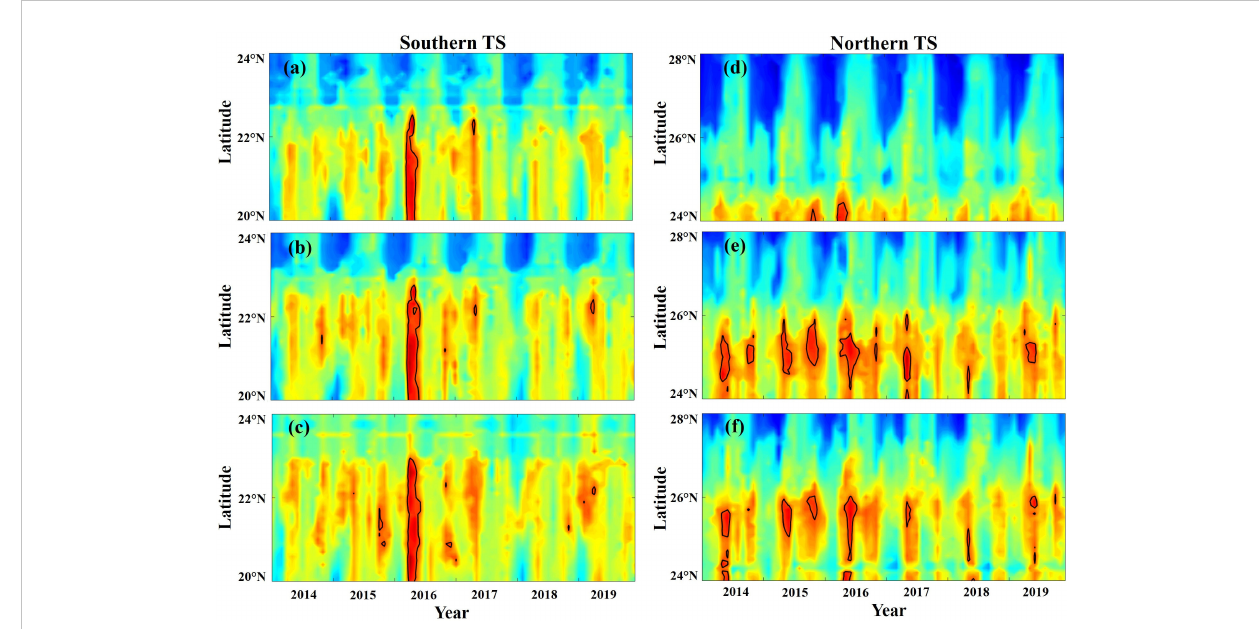
FIGURE 13 Time-series latitudinal section plots of the greater amberjack habitat suitability index (HSI) along the southern and northern Taiwan Strait: (A) 118°E, (B) 119°E, (C) 120°E, (D) 122°E, (E) 123°E, and (F) 124°E; the maps were generated using an arithmetic mean model developed using marine environmental data from 2014 – 2019. The black solid line outlines the areas with an HSI value of